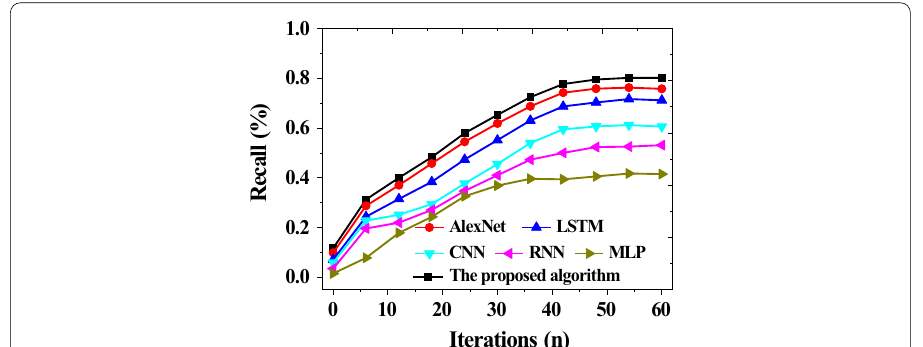
Fig. 7 Recall curves of different algorithms with the increase of iteration times